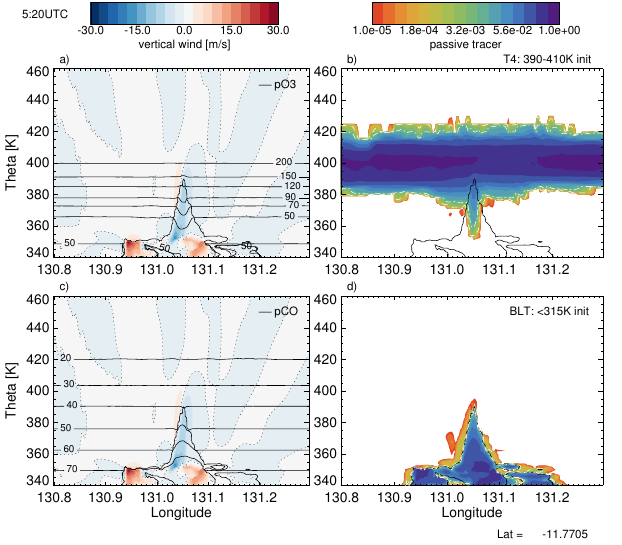
Figure 8. Cross sections through the cloud top at 05:20UTC. The left panels show the vertical wind (coloured contours) over- lain by p O 3 isolines (a) and p CO isolines (c) . The right panels show coloured contours of the T4 (b) and BLT (d) tracers. The 0.01gkg − 1 cloud contour is displayed on all cross sections. The white dashed/dash-dotted lines indicate the 0.1 and 1% thresholds of the tracer’s original value.